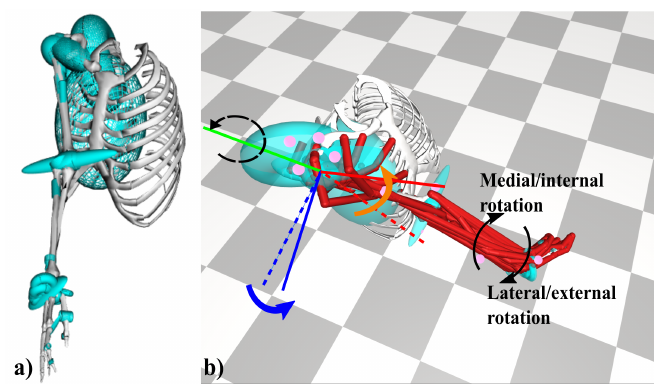
Figure 4. ( a ) Allowable joint motion limit, ( b ) Shoulder joint alignment, origin (dashed line) and humerous (solid line)